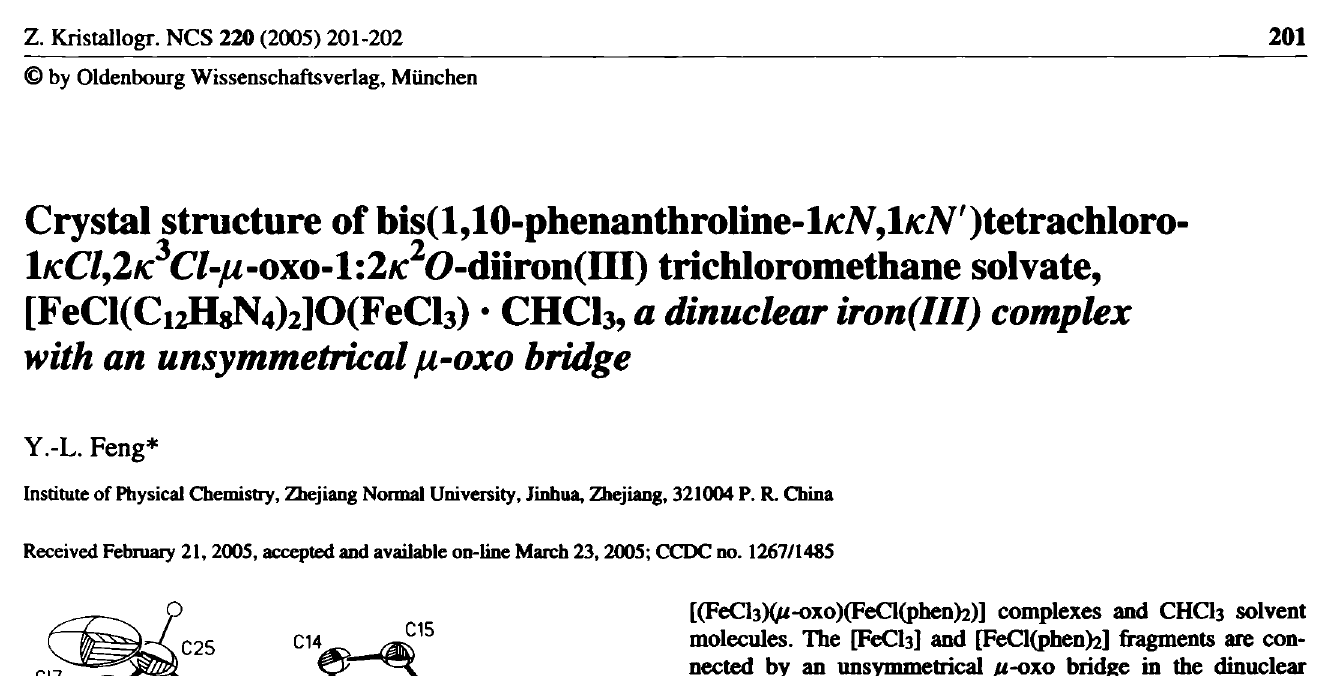
Table 1. Data collection and handling.